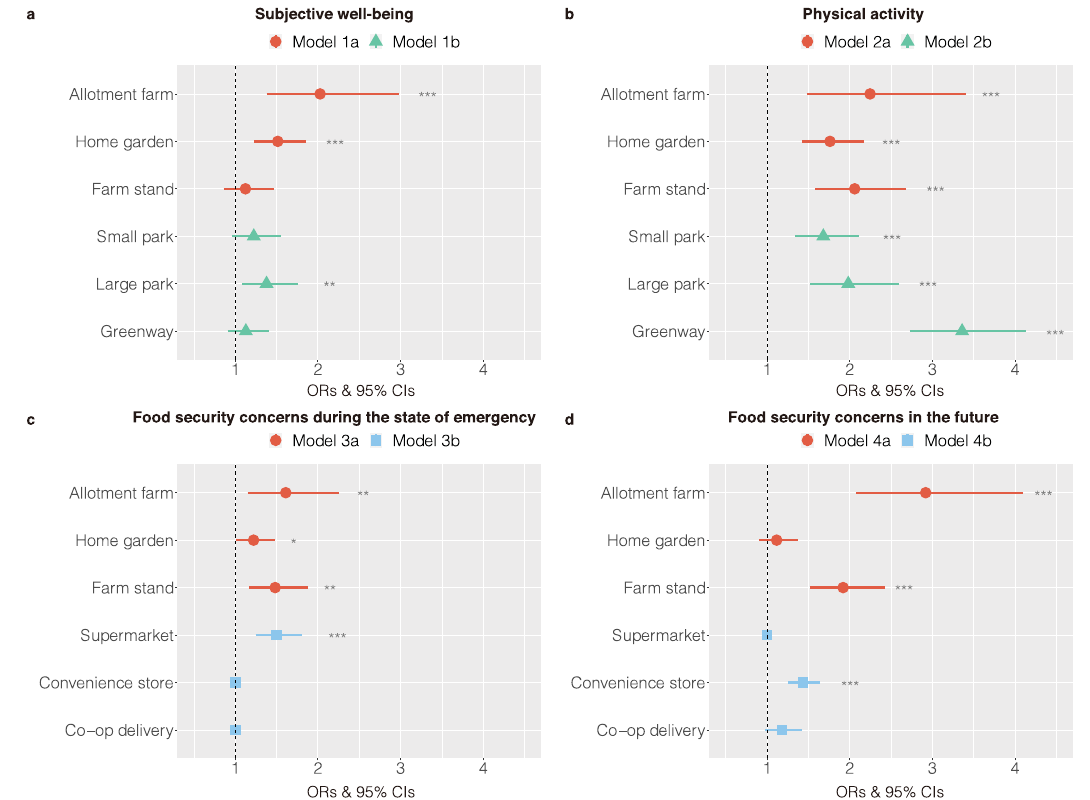
Fig. 3 The associations between local food access and health and food security during the COVID-19 pandemic. a , b The associations of access to local food and other urban green spaces with subjective well-being ( a ) and physical activity ( b ). c , d The associations of access to local food and other food purchasing places with food security concerns during the state of emergency ( c ) and in the future ( d ). The circle (red), triangle (green), and square (blue) symbols indicate the ORs. The vertical dashed line is the reference line and is set to one. The error bars represent the 95% CIs. Predictors are interpreted to be signi fi cant if their 95% CIs do not cross one line. The signi fi cant results are shown as follows: * p < 0.05, ** p < 0.01, and *** p < 0.001.